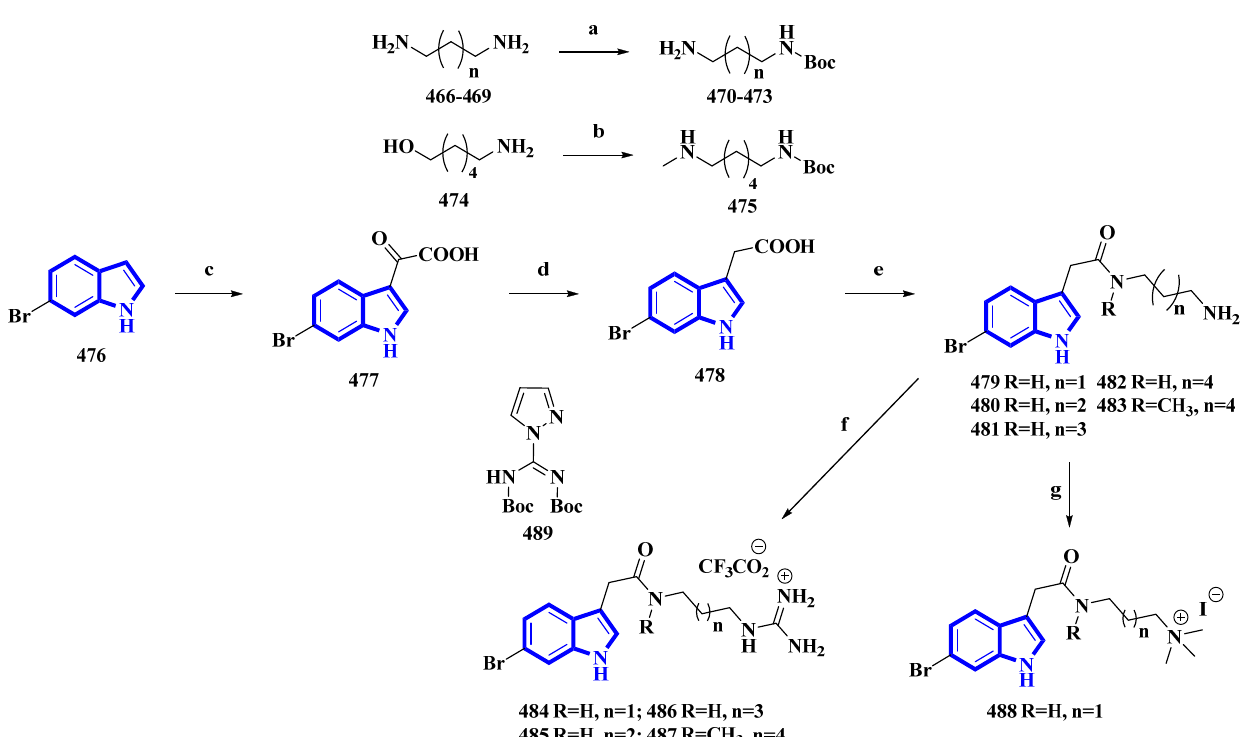
Figure 24. Synthesis of phidianidine A derivatives 479 to 488 . (a) Boc 2 O, rt, overnight, 93–95%; (b) (1) Boc 2 O, Et 3 N, rt, 2 h, (2) MsCl, Et 3 N, 0 °C, 5 h and (3) CH 3 NH 2 , 60 °C, 1 h, 58%; (c) oxalyl chloride,